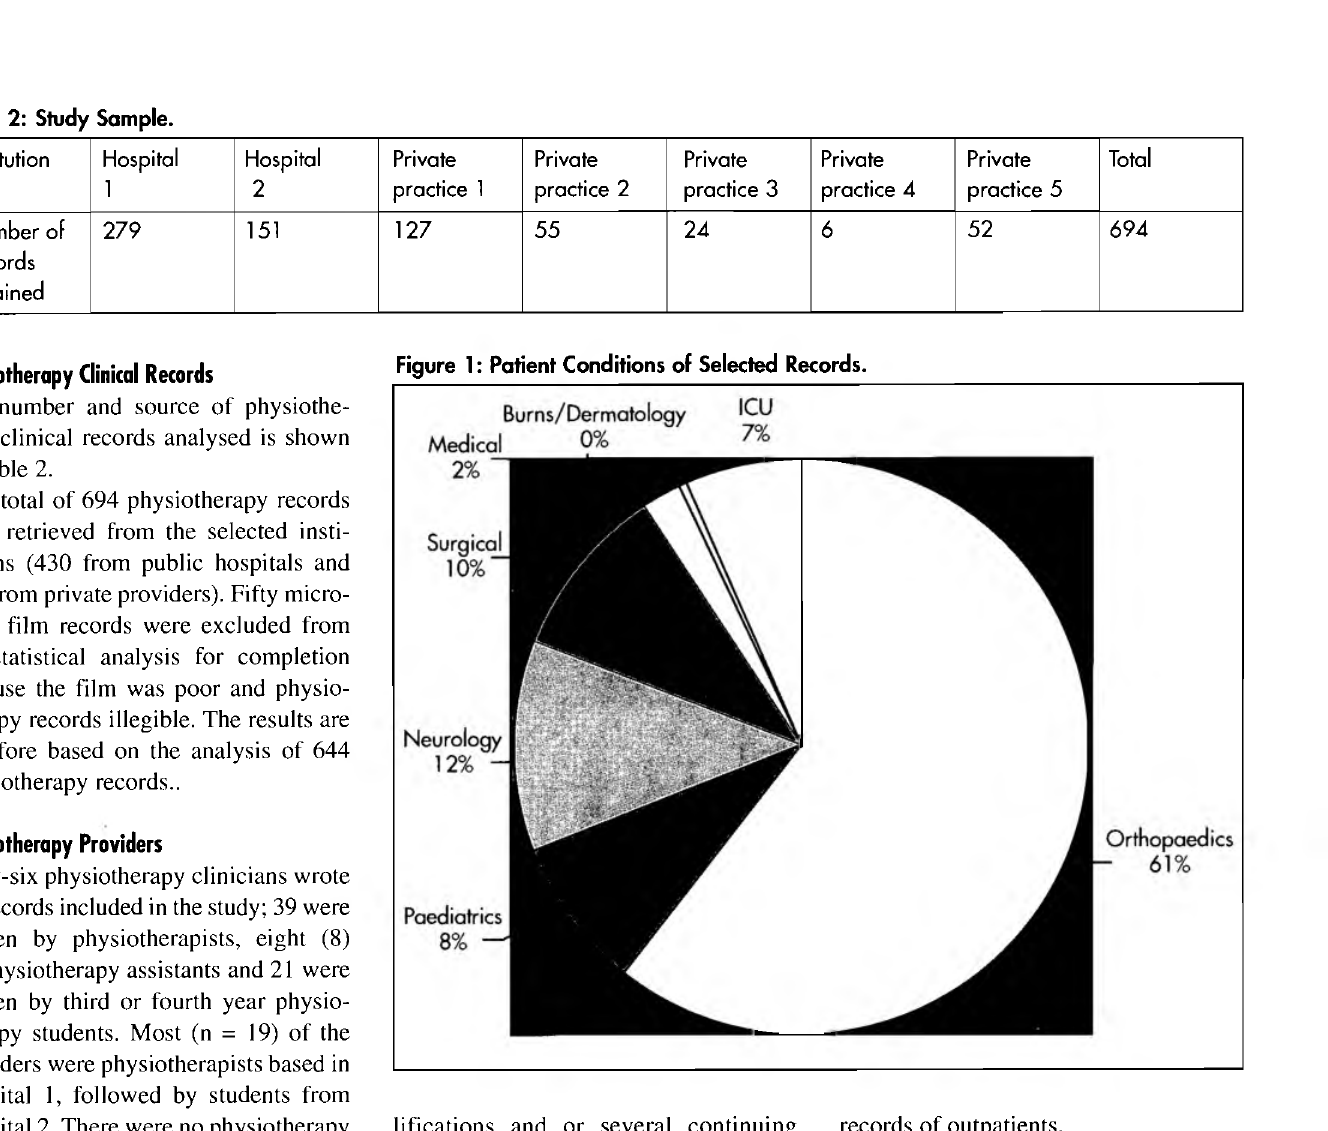
Table 2: Study Sample.